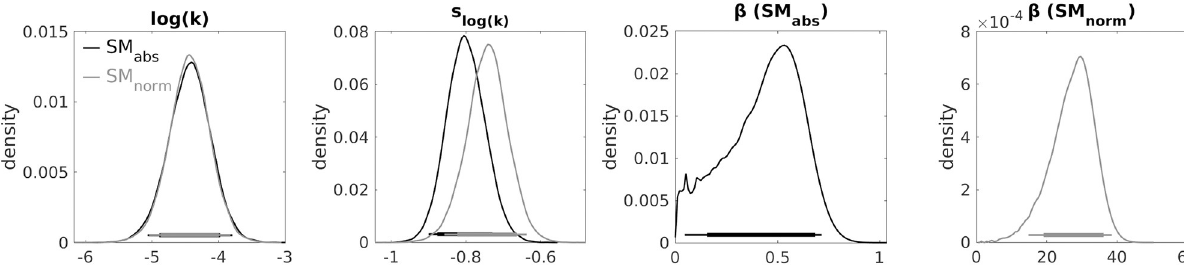
Fig 1. Posterior distributions of the group-level parameter means from the softmax models based on absolute (SM abs ) and normalised (SM norm ) values. log ( k ): discounting parameter, s : shift in log ( k ), β : inverse temperature parameter. Horizontal solid lines indicate the 85% and 95% highest density interval.